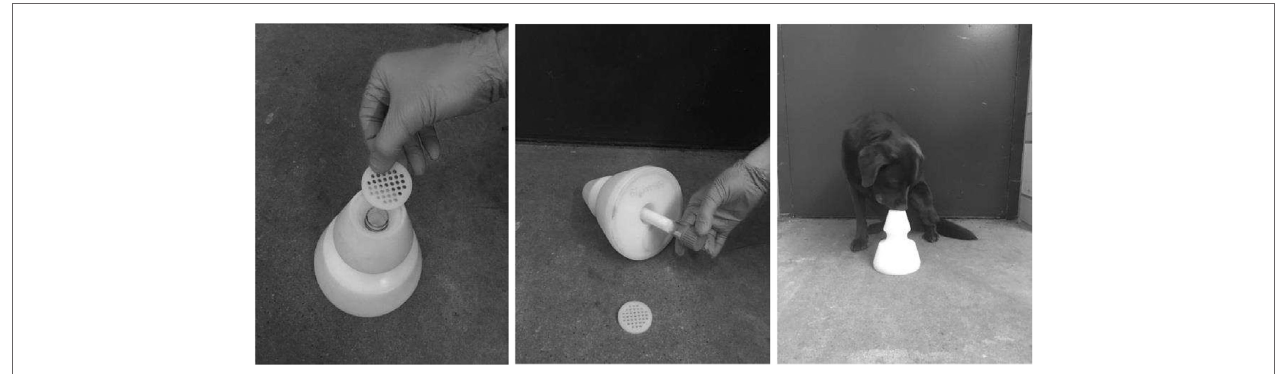
FigUre 1 | Polyethylene cone for presenting glass tubes to dogs in training and testing. Left picture: perforated plate changed after every contact of a dog’s nose; middle picture: glass tube with air sample attached to fleece is inserted into cone. Right picture: dog indicates a cone with a sitting